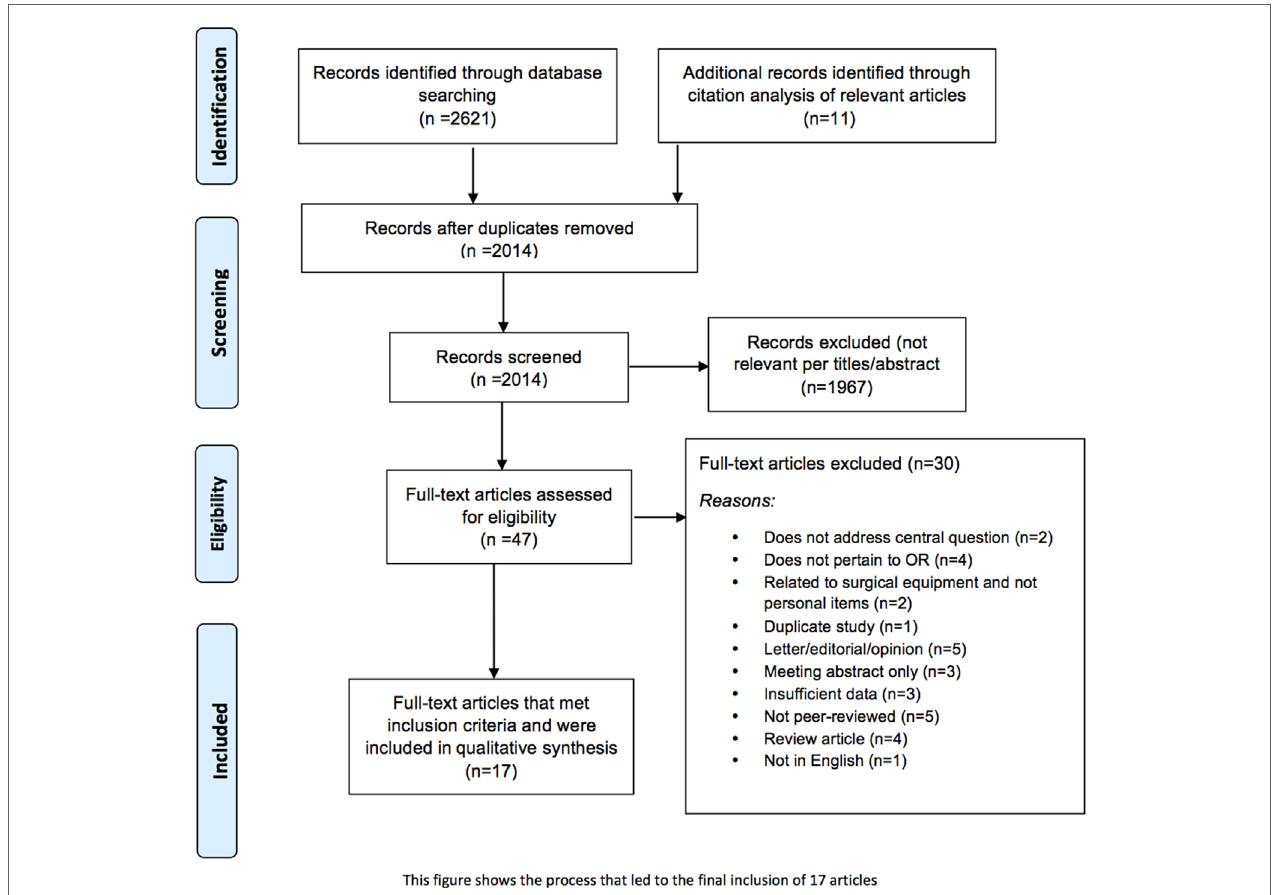
FiGUre 1 | Flowchart of the process of literature search and extraction of studies meeting the inclusion criteria